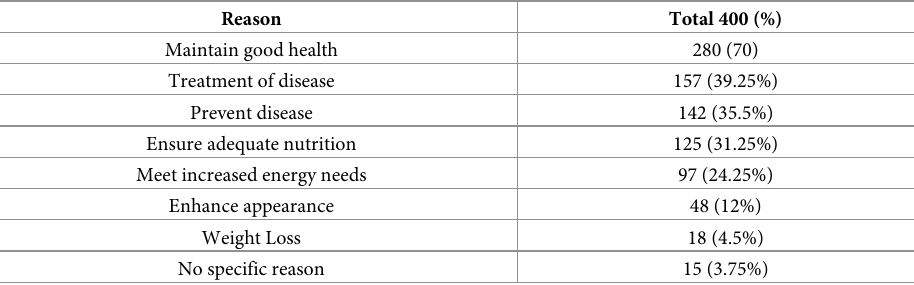
Table 6. Patient’s perception on reason for nutraceutical use.